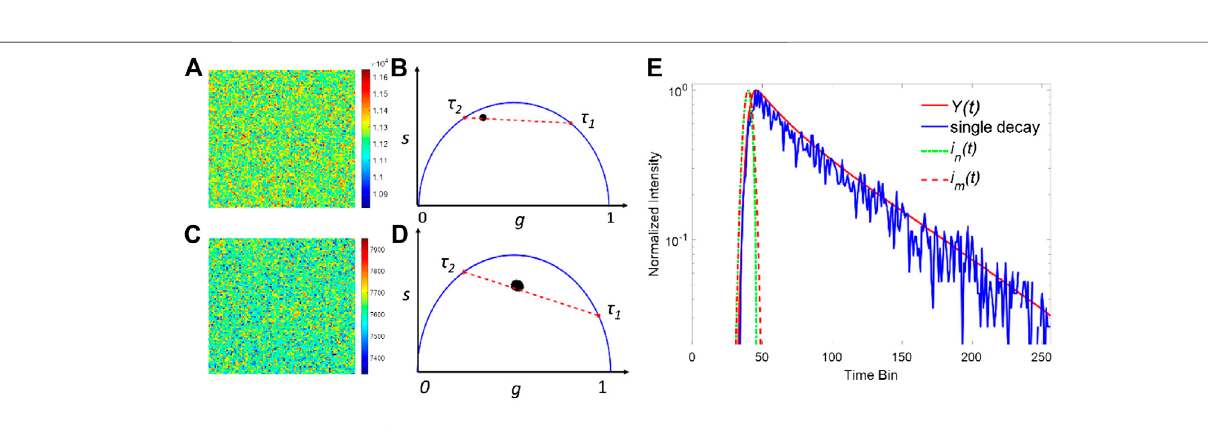
FIGURE2| SimulatedFILMimageswith a (cid:2) 0.6, τ 1 (cid:2) 0.8 ns, τ 2 (cid:2) 2.8 ns,and N c (cid:2) 10,000for (A) and a (cid:2) 0.2, τ 1 (cid:2) 0.4 ns, τ 2 (cid:2) 2.8,and N c (cid:2) 5000for (C) . (B,D) are the corresponding phasor plots of (A,C) . (E) Normalized intensity plots for Y(t) and the single decay in a pixel in (A) . Generated synthetic IRFs using the total decay are depicted in dash